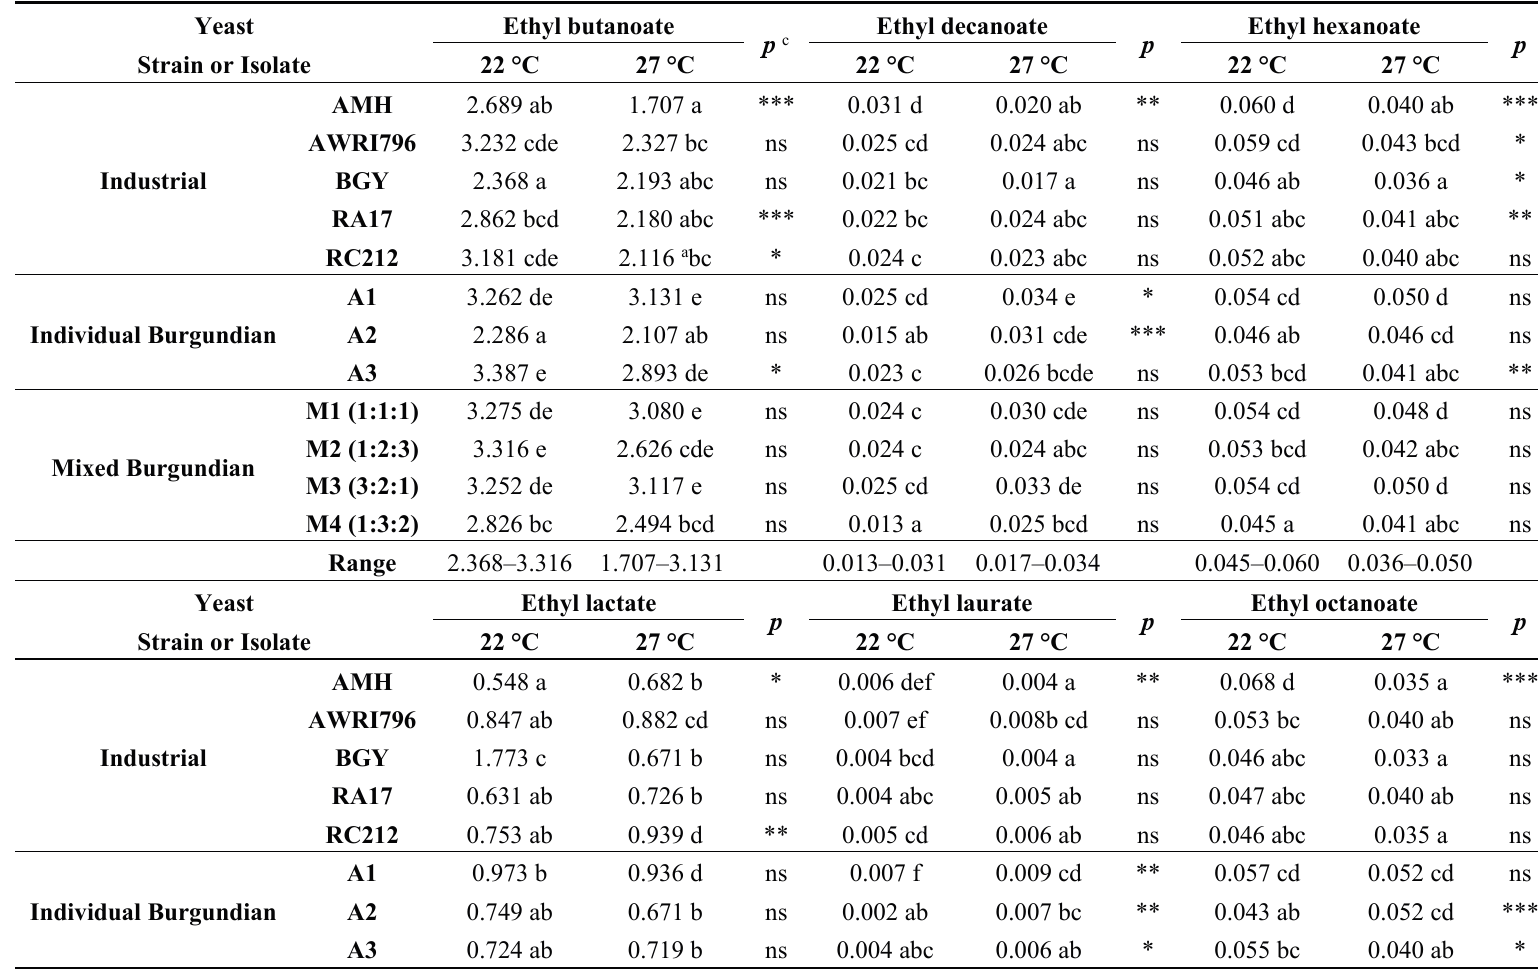
Table 3. Ethyl esters (mg·L − 1 ) a,b in Pinot noir fermented with industrial strains and individual- and mixed-Burgundian S. cerevisiae isolates, at 22 °C and 27 °C. For each determination, strain and temperature effects are shown with subscripts and p values,